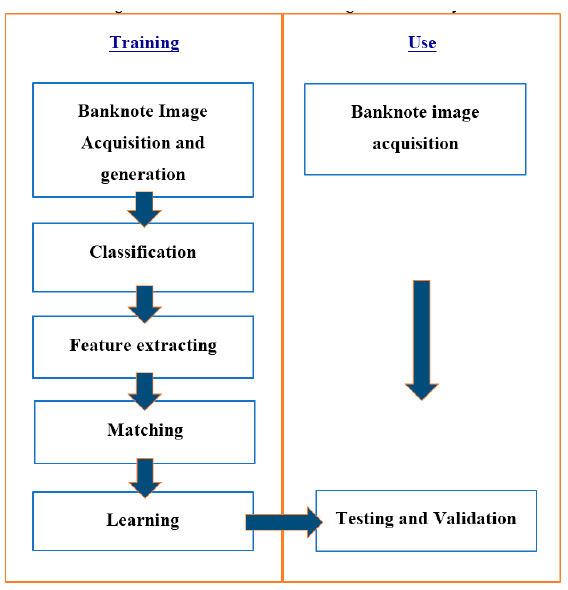
Figure 2. Block diagram of the proposed method.